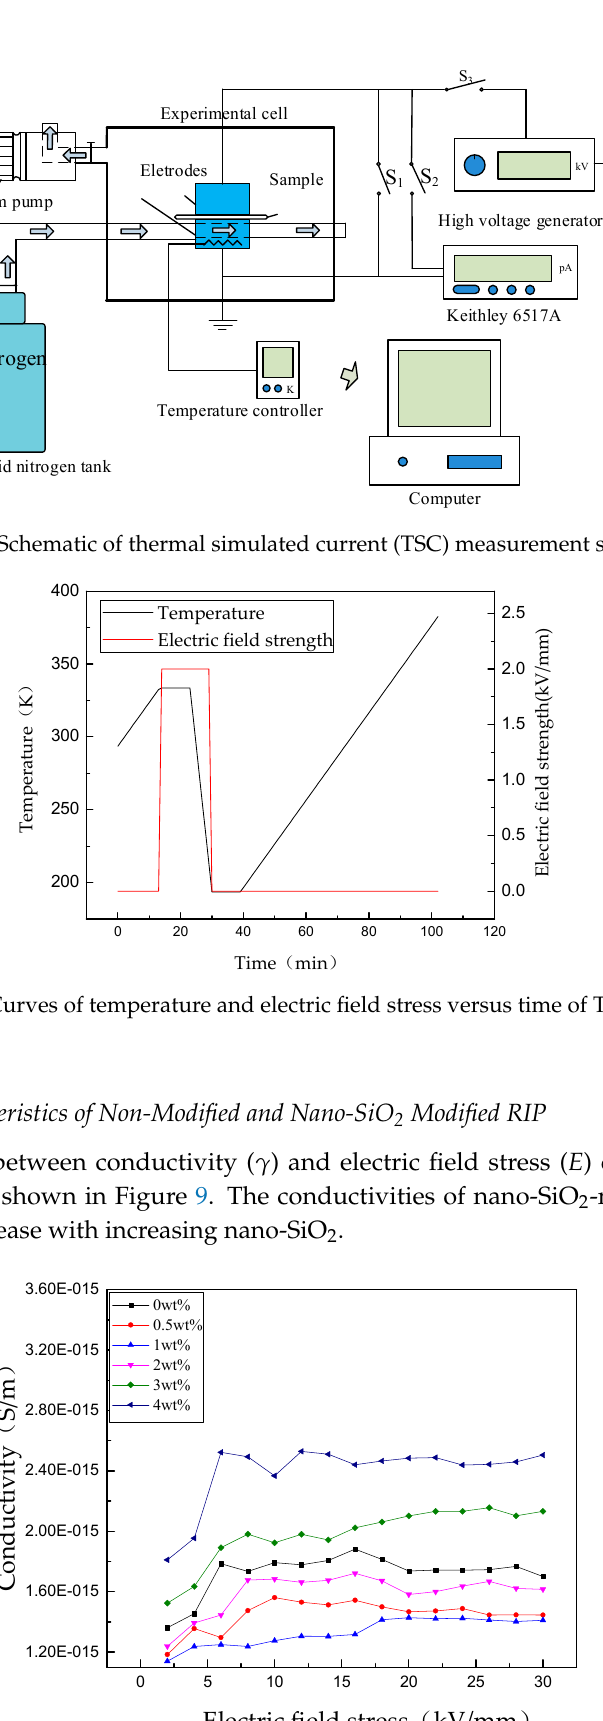
25mm Figure 6. Direct-current (DC) breakdown electric field strength test system. To characterize the trap parameters of epoxy non-modified and nano-SiO